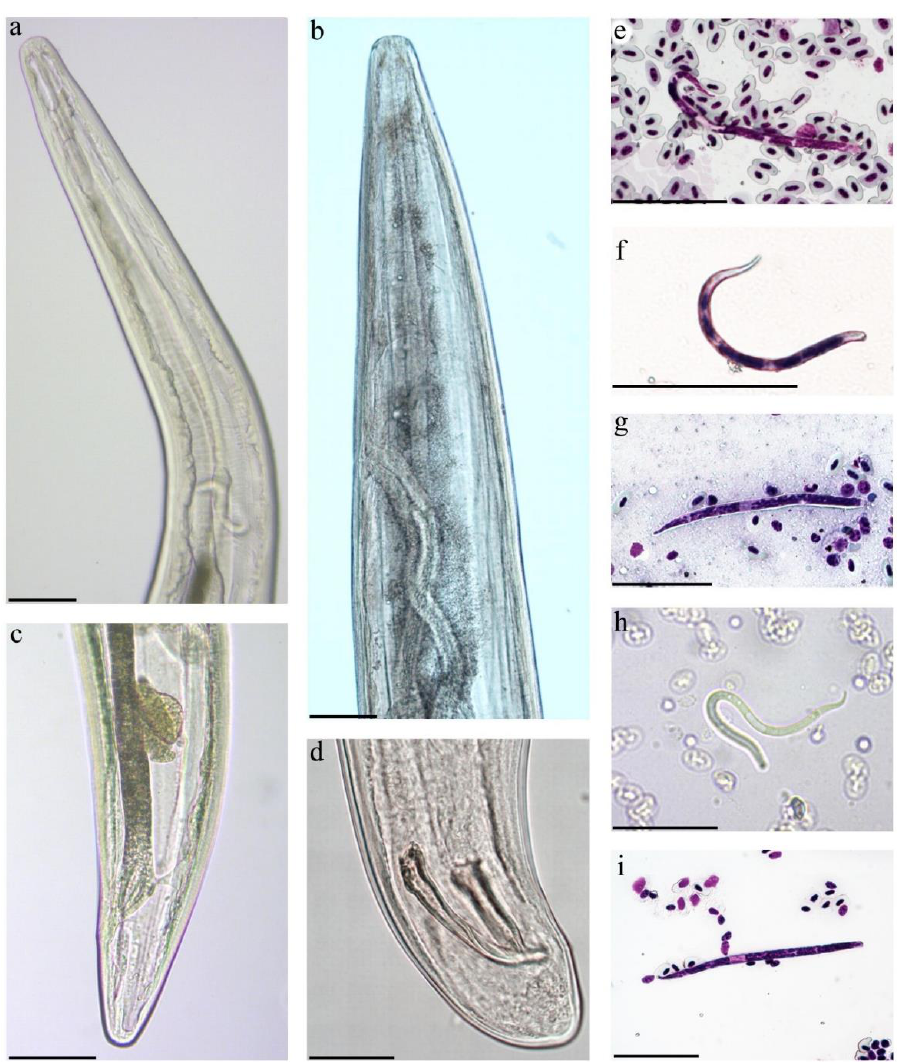
Figure 4. Splendidofilaria mavis from a Eurasian blackbird ( Turdus merula ) ( a – g ) and a Song thrush ( Turdus philomelos ) ( h , i ). Male anterior extremity (alive worm) ( a ). Female anterior extremity (alive worm) ( b ). Female posterior extremity (alive worm) ( c ). Male posterior extremity (ethanol-fixed worm) ( d ). Microfilariae from peripheral blood, Giemsa-stained ( e , i ). Microfilariae obtained from female uterus, Giemsa-stained ( f ). Microfilariae from liver blood films, Giemsa-stained ( g ). Alive microfilaria in blood ( h ). Scale bars: 100 µm ( a , b ); 50 µm ( c – i ). Adult nematodes are slender with slightly attenuated extremities, males are shorter than females, the cuticle is without bosses, the oral opening is small, the oesophagus is thin, it is not externally divided into muscular and glandular part, the vagina is short, directed posteriorly, the spicules are subequal and dissimilar (Figure 4a–d). The morpho- metric parameters of adult S. mavis in both bird species are similar (Table 4). Although, S. mavis as described from the Song thrush had a shorter oesophagus, a vulva that opens further from the anterior extremity and an ovary that turns up father from posterior ex- tremity in comparison to the Eurasian blackbird, but it corresponds with the descriptions